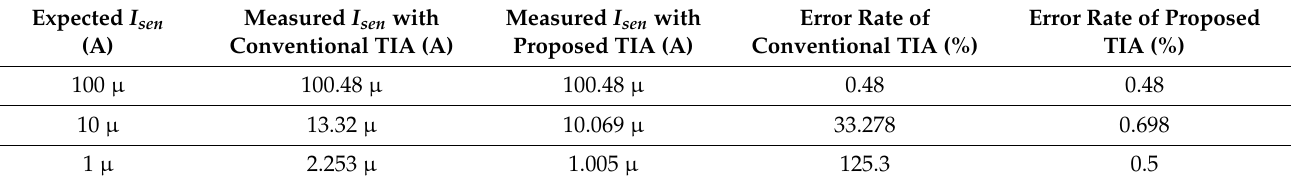
Table 2. Extracted I sen and error rates with the conventional TIA and proposed